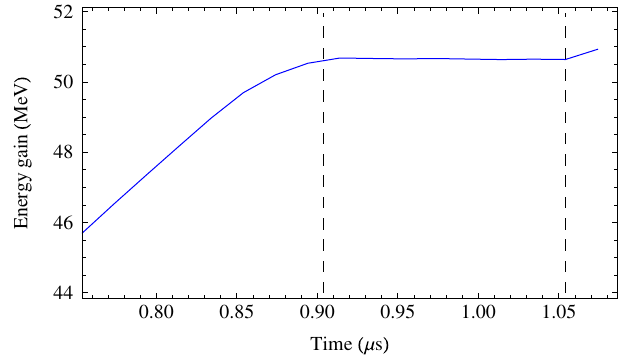
FIG. 3. Energy gain as a function of time through a 5.2-meter constant-gradient linac with beam and with constant rf drive. Injected current is 100 mA. The dashed lines delimit beam